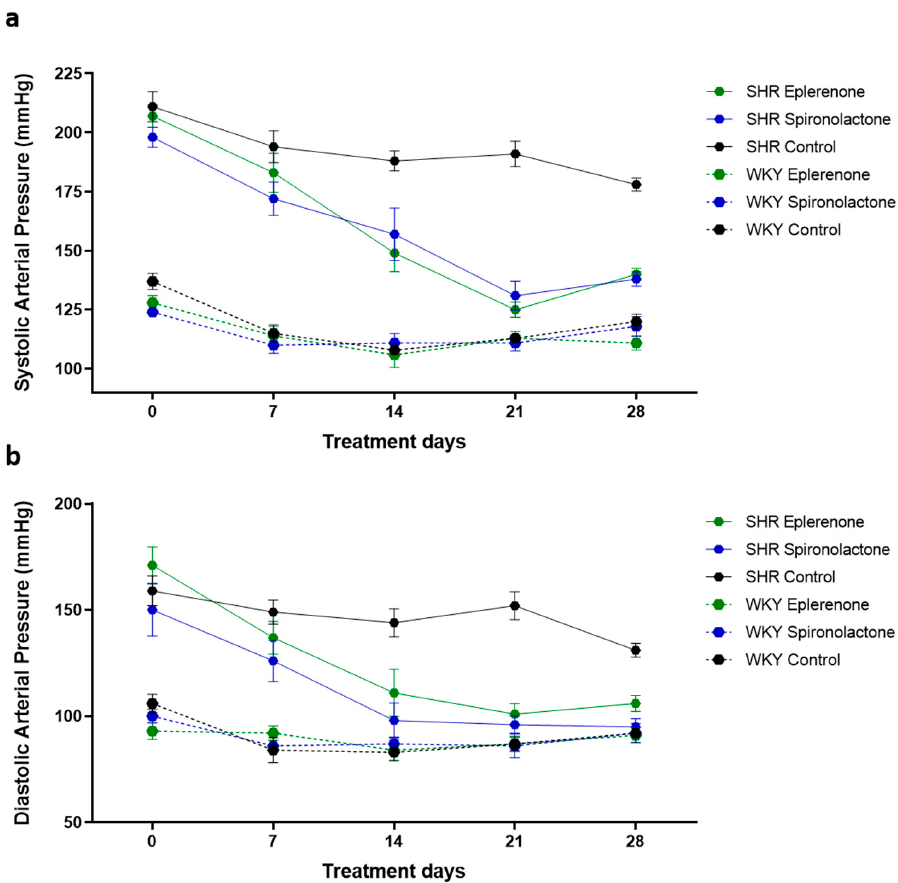
Figure 1. Systolic ( a ) and diastolic ( b ) blood pressure values of Wistar Kyoto (WKY) and Spontaneous Hypertensive rats (SHR), before and 7, 14, 21, and 28 days after treatment with eplerenone or spironolactone. After 21 days of treatment, SHR treated with spironolactone or eplerenone reached blood pressure values similar to those observed in normotensive rats. The arterial blood pressure of the normotensive rats was not affected by MRAs treatment.